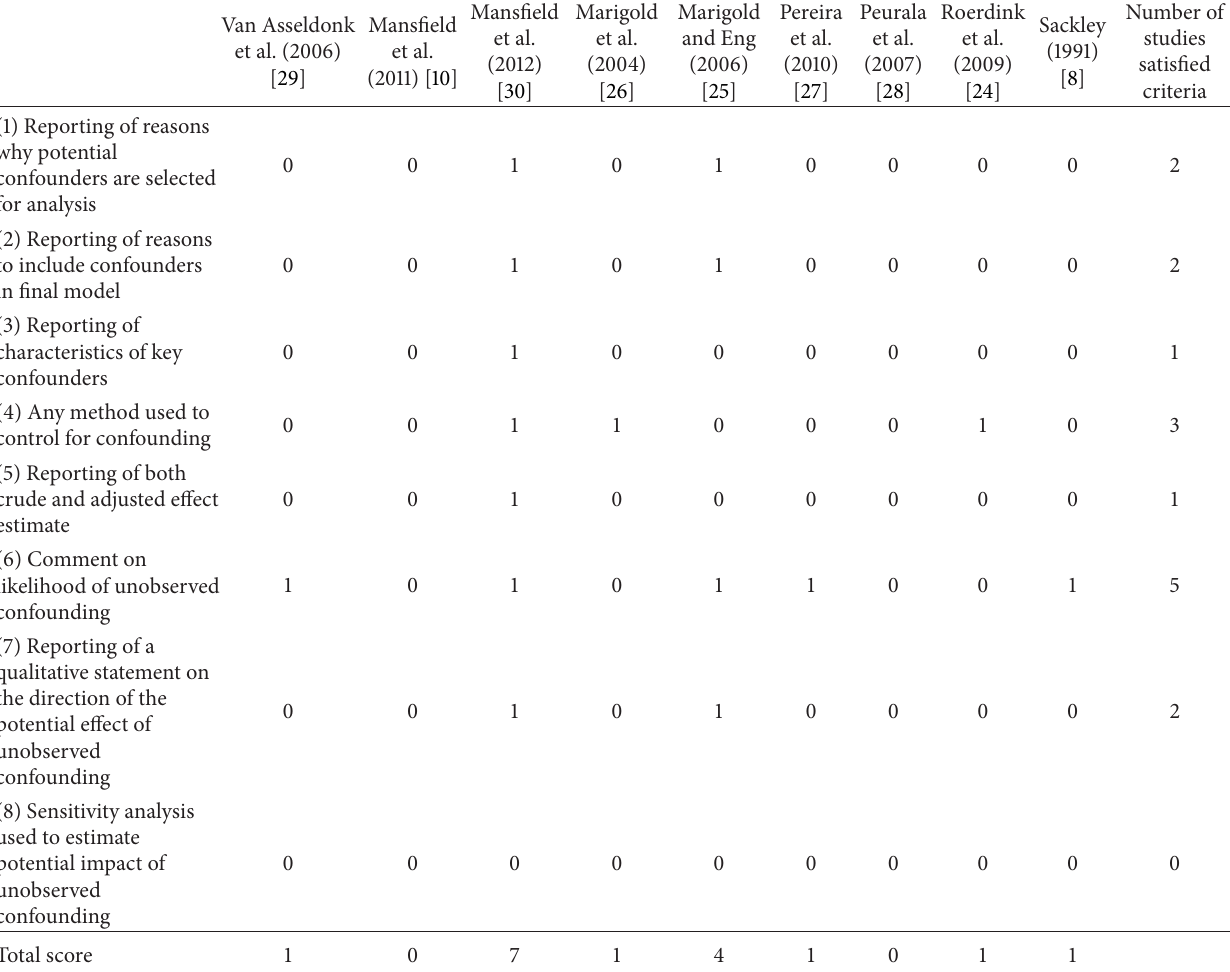
Table 3: Reporting of confounding bias in individual studies